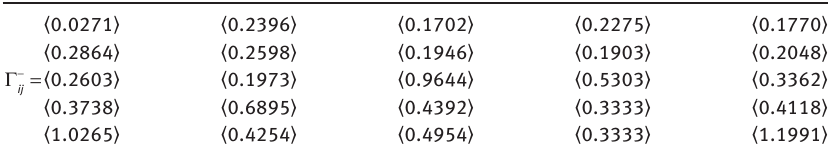
Table 17: The Gray Relational Coefficient of each Candidate from